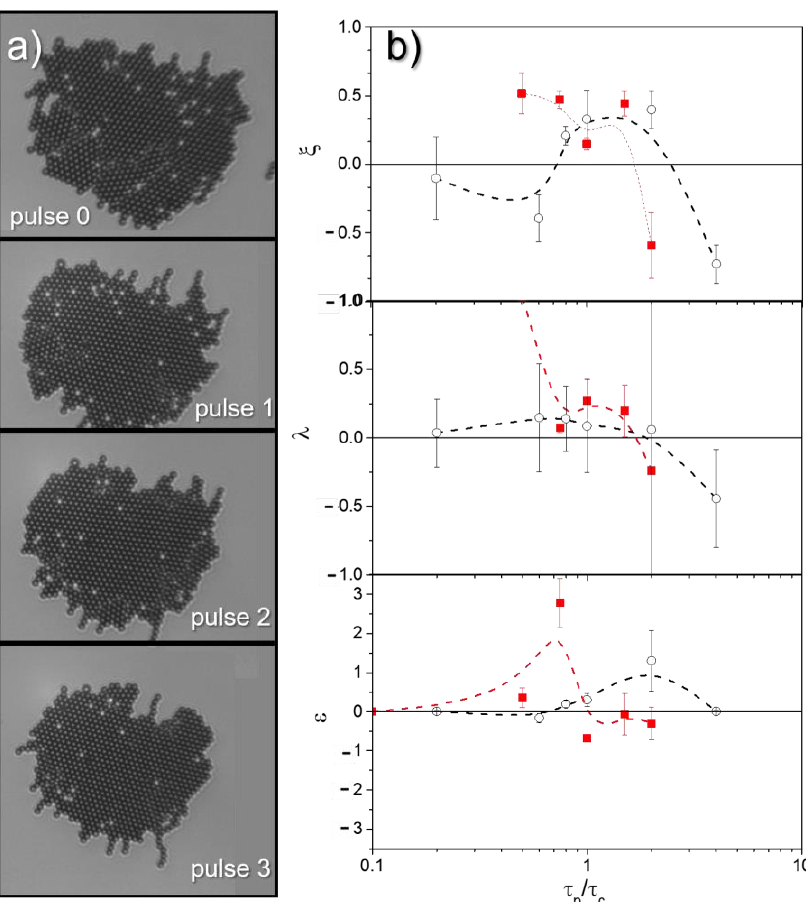
Figure 3. ( a ) The sequence of microscope images shows how the application of a consecutive series of field pulses oriented perpendicular to the fluid interface, where particles are adsorbed, allows the melting of grain boundaries and defects, thus improving crystallinity. ( b ) In small polycrystals composed of between 100 and 500 particles, the pulse application can alter the values taken by the parameters ξ, α and ε , which evaluate the degree of enhancement of the hexagonal order and are defined throughout the text. These parameters take positive values when the pulse duration is close to the time it takes for the outer particles to travel a radius of distance under the action of the pulses, τ c . µ 0 𝐻 𝑡𝑜𝑡𝑎𝑙𝑒𝑥𝑡 = µ 0 √𝐻 02 + (𝐻 𝑧𝑚𝑎𝑥 ) 2 = 2.0 and 8.0 mT for the black circles and the red squares, respectively.